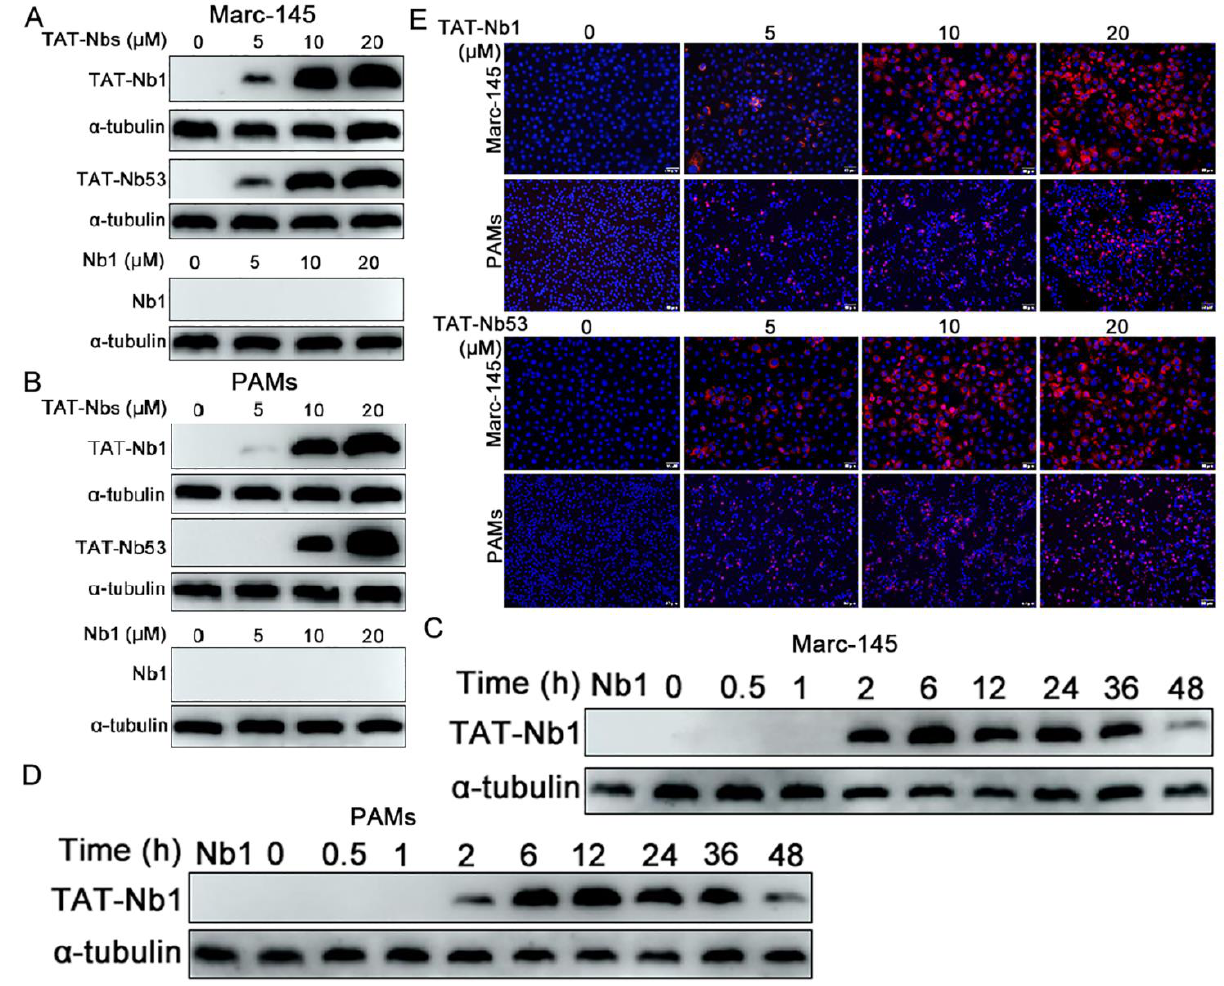
Figure 2. Transduction of TAT - Nb1 and - Nb53 proteins into Marc - 145 cells and PAMs. Marc - 145 cells (0.5 × 10 5 cell/well) and PAMs (0.5 × 10 6 cell/well) were seeded into 24 - well cell culture plates. When reaching about 80% confluence, the cells were incubated with TAT - Nb1, - Nb53 (0, 5, 10, and 20 μM), and control Nb1 protein for 6 h. Then, Western blot was performed to analyze the entry of TAT - Nbs or Nb1 into Marc - 145 cells ( A ) and PAMs ( B ). Then, 20 μM TAT - Nb1 or - Nb53 was added to Marc - 145 cells ( C ) and PAMs ( D ), respectively, to analyze the stability of transduced TAT - Nbs. ( E ) IFA detection of the transduced TAT - Nbs protein into Marc - 145 cells ( E ) and PAMs ( F ). Scale bar = 50 μm.